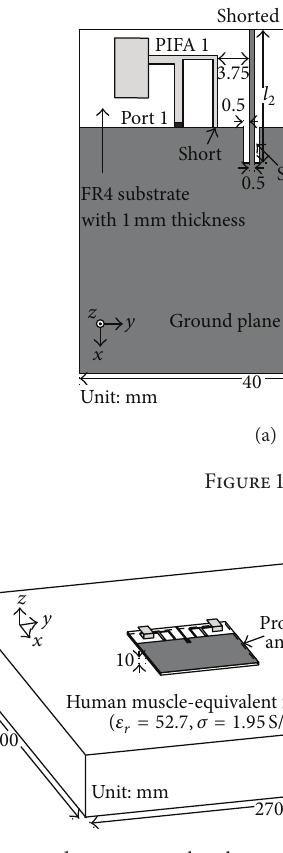
Figure 2: Proposed antenna on the phantom for simulation setup.